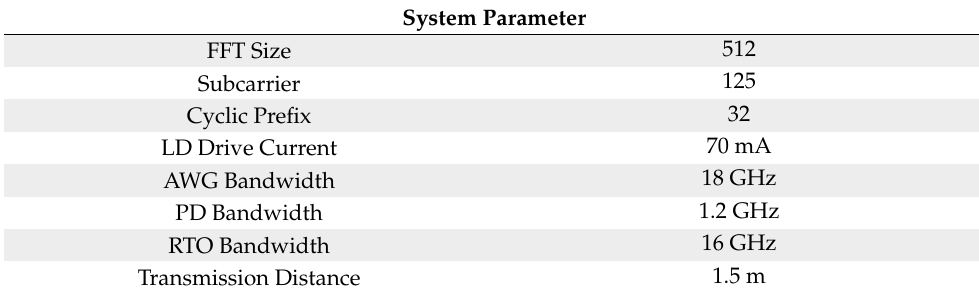
Figure 2. Experiment of the proposed PowDM VLC system. AWG: arbitrary waveform generator; RTO: real-time oscilloscope. Inset: a photo of the experimental setup. Table 1. System Parameters.